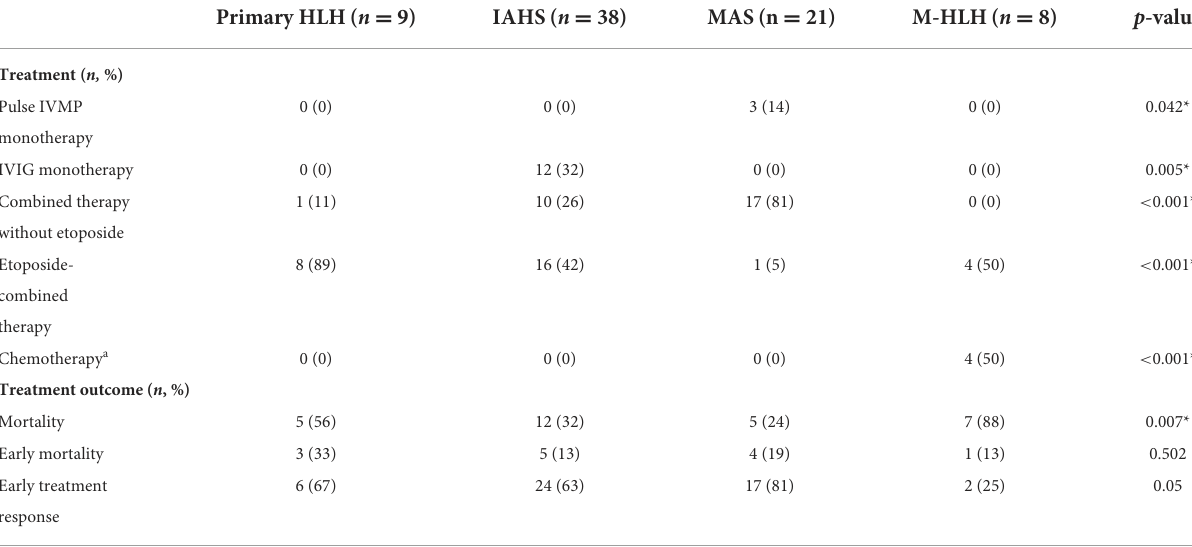
TABLE 2 Treatment and treatment outcomes in HLH patients with different